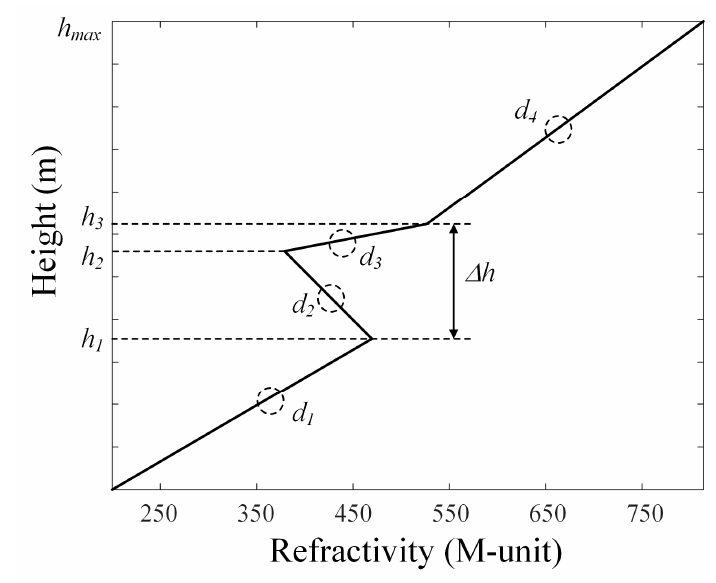
Figure 3. Quad-linear model of the modified refractivity according to the altitude.